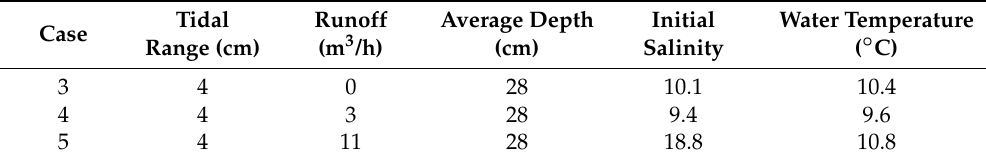
Table 2. The conditions of Case 3, Case 4 and Case